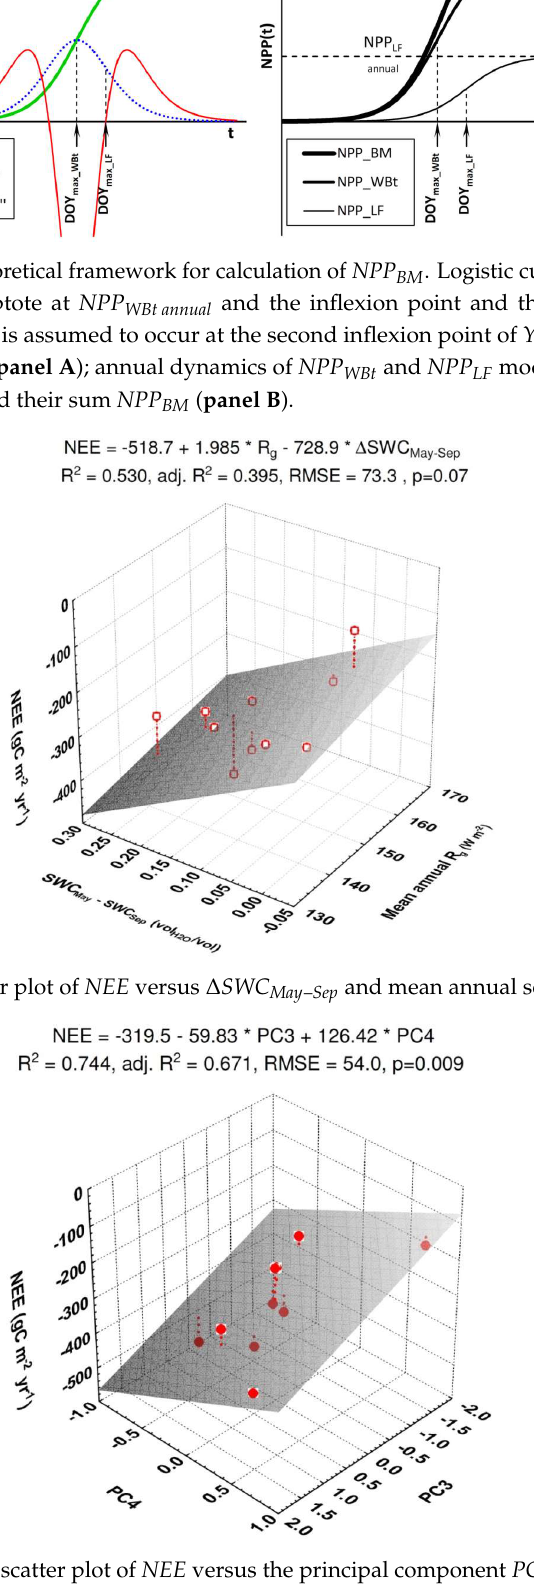
Figure A5. Cumulative fluxes ( NEE , GPP , R ECO and NPP ; panels A – D , respectively) estimated with EC during the period of the study.